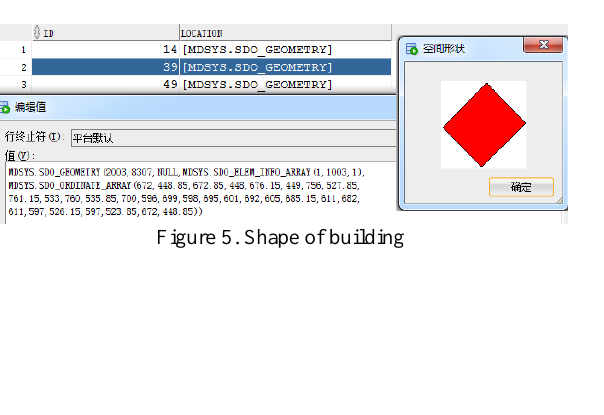
Figure 6. Contrast before and after Morton code